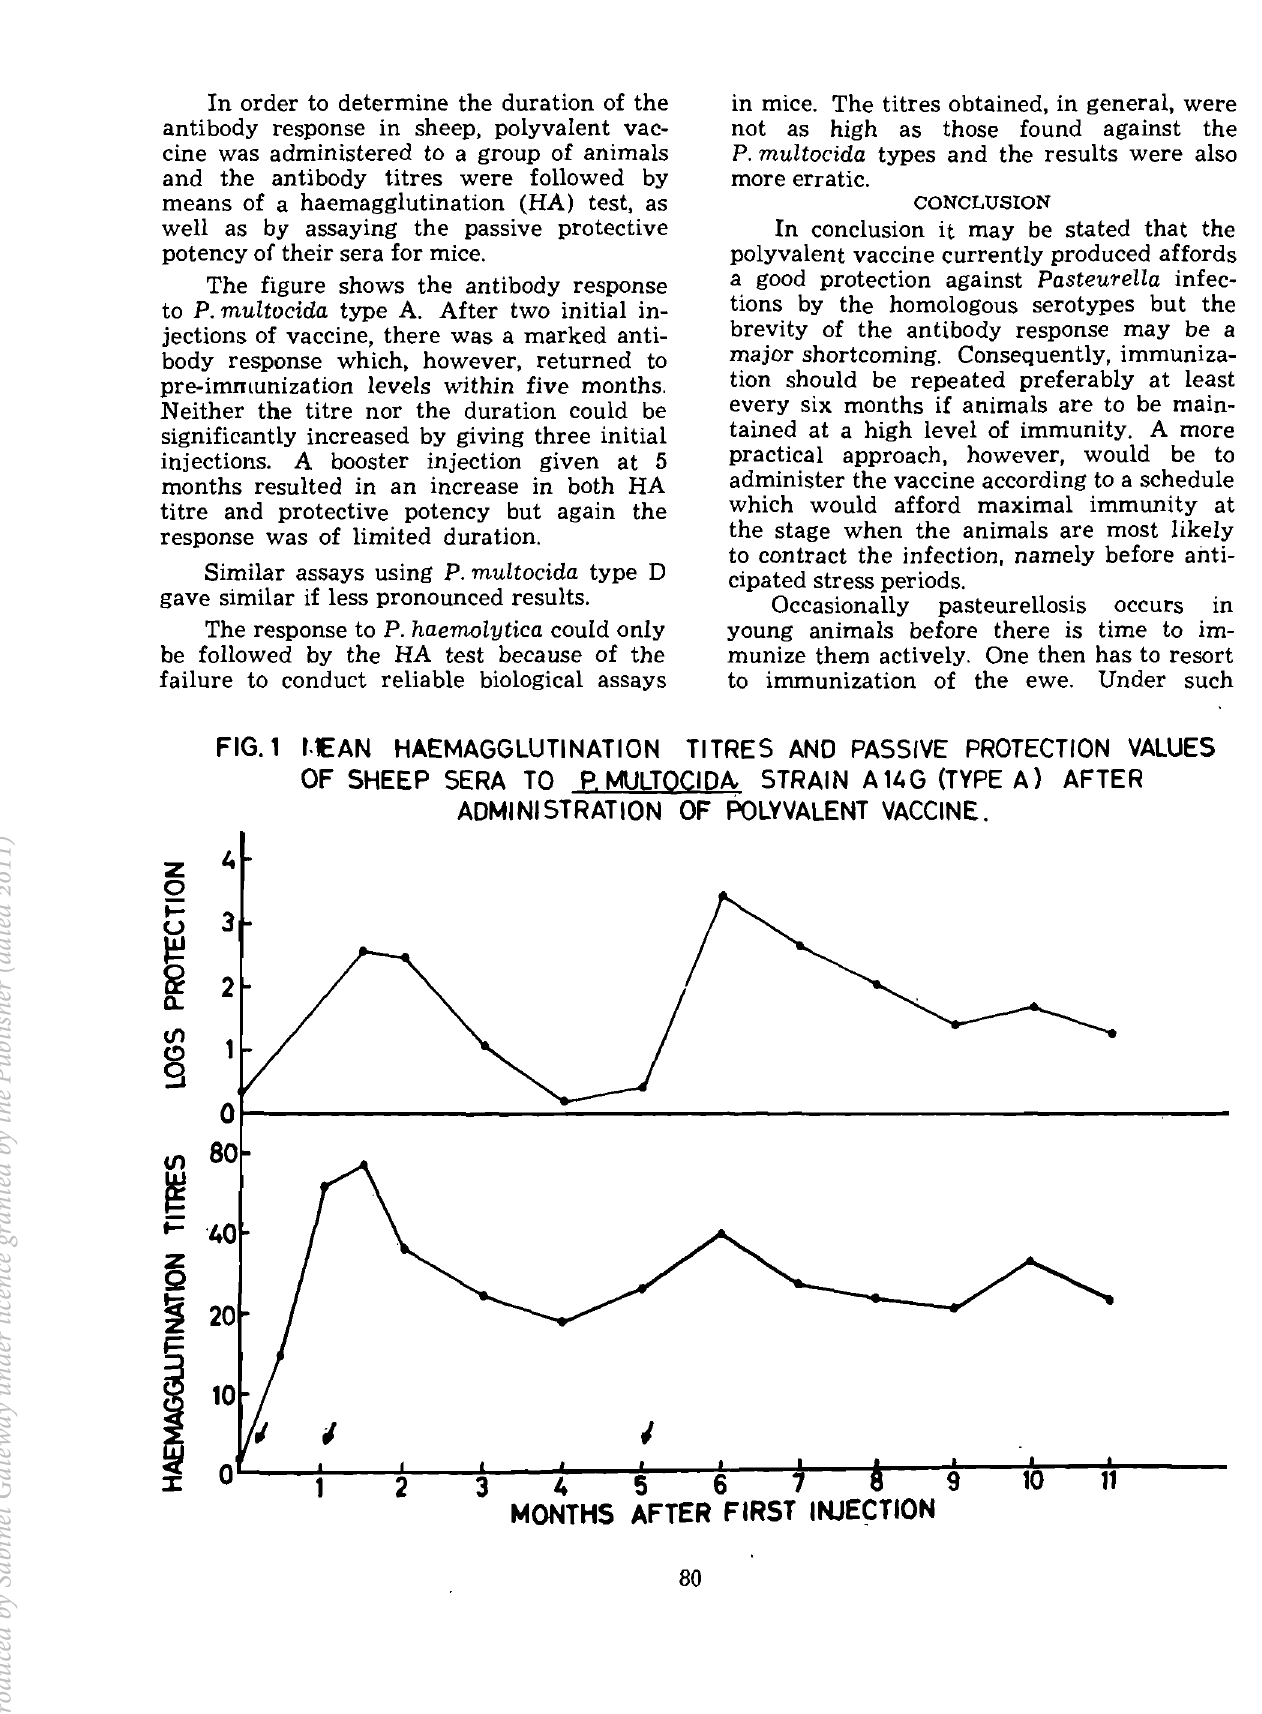
FIG. 1 J·£AN HAEMAGGLUTINATION TITRES AND PASSIVE PROTECTION VALUES OF SHEEP SERA TO P. MULTOCIOA STRAIN A 14G (TYPE A) AFTER ADMINISTRATION OF PoLYVALENT